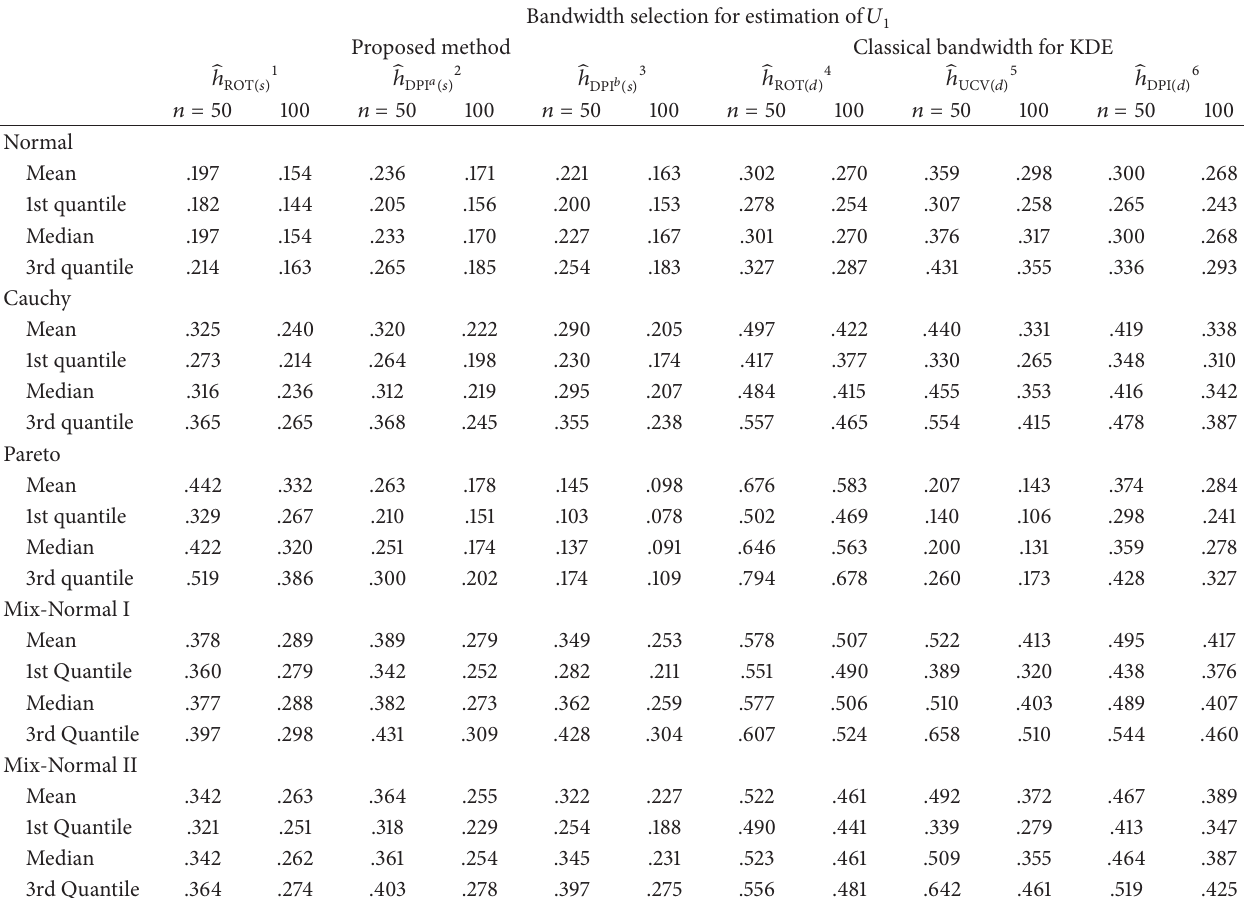
Table 1: Optimal bandwidth selection in estimation of 𝑈 1 with comparison to classical bandwidth selection